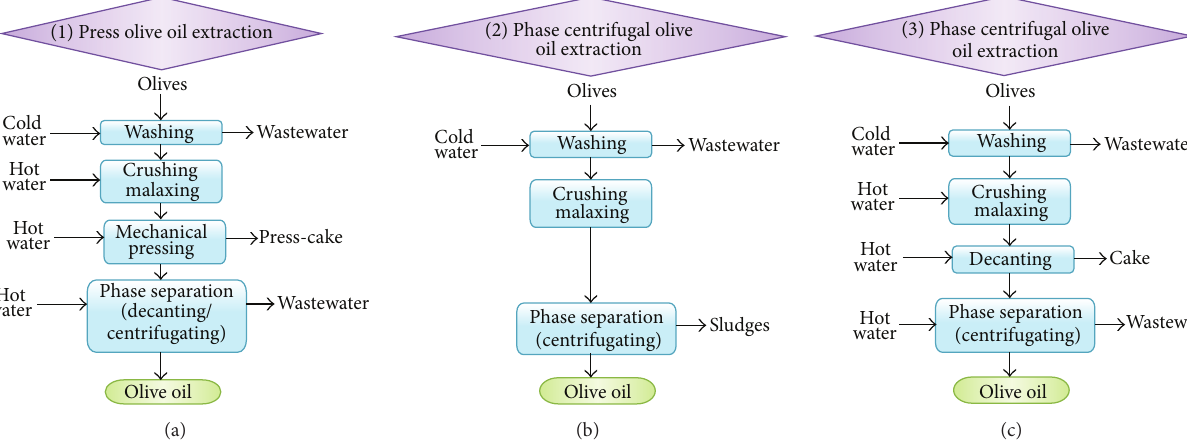
Currently, the main olive process method used in